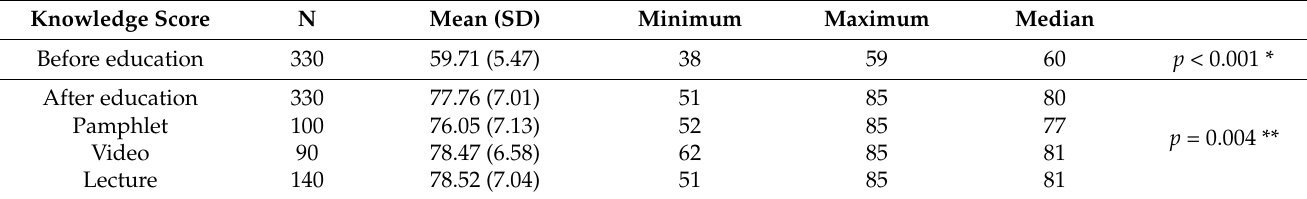
Table 1. The results of the general knowledge on oral health before and after education.